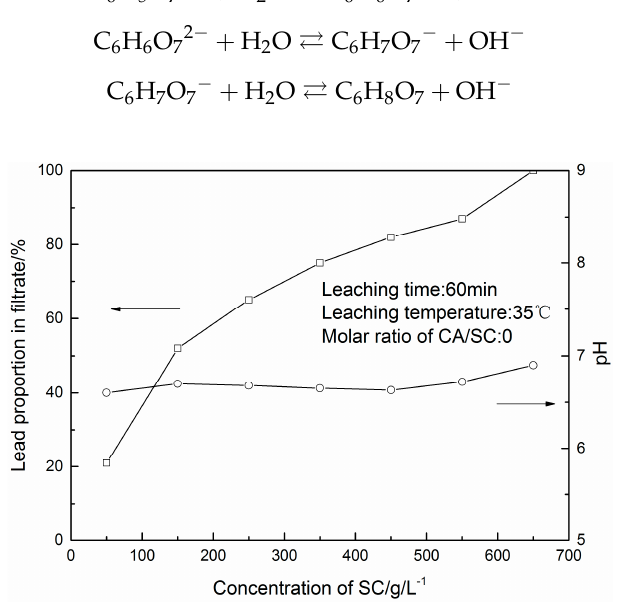
Figure 3. Lead proportion in filtrate with different concentrations of SC (leaching time is 60 min, leaching temperature is 35 °C, molar ratio of CA/SC is 0).